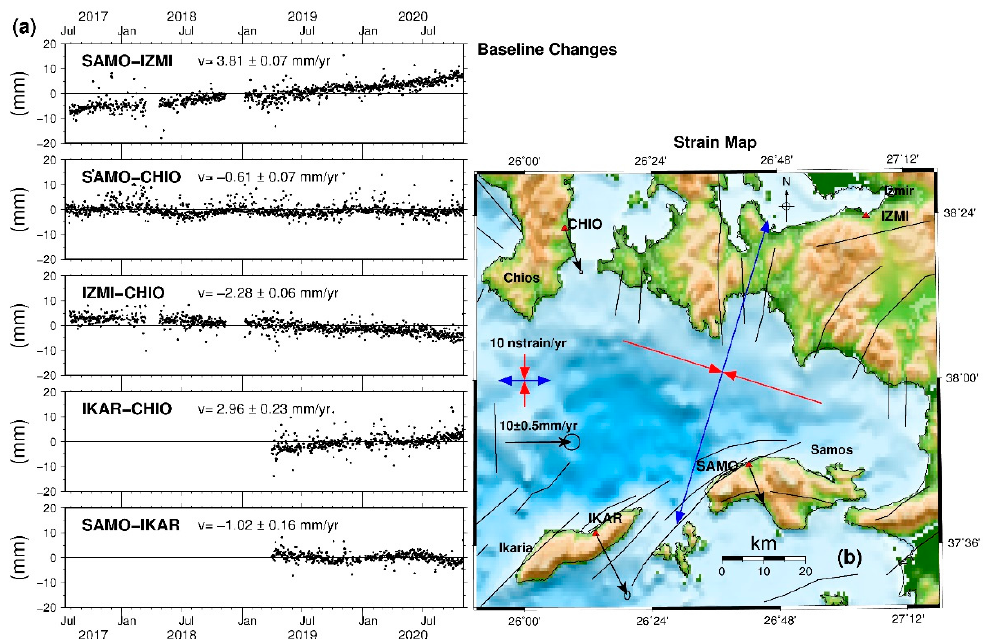
Figure 4. ( a ) The daily baseline changes between the four local continuous GNSS stations for the period before the Mw6.9 earthquake, normalized to an average value. ( b ) Map of the strain tensor (blue arrow for extension, red arrow for compression) and the horizontal velocity vectors (black arrows) for the GNSS stations relative to station IZMI. Error ellipses in all figures have been drawn to the 95% confidence interval.